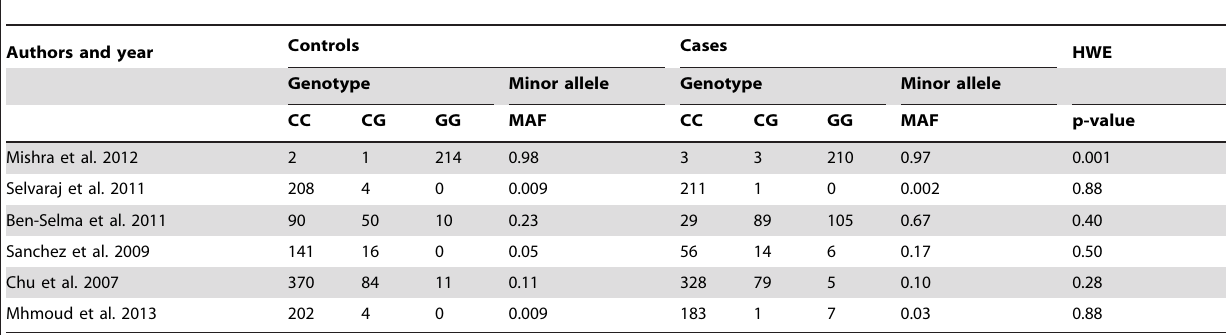
Table 2. Distribution of CCL5 -28 C . G polymorphism of studies included in the meta-analysis.